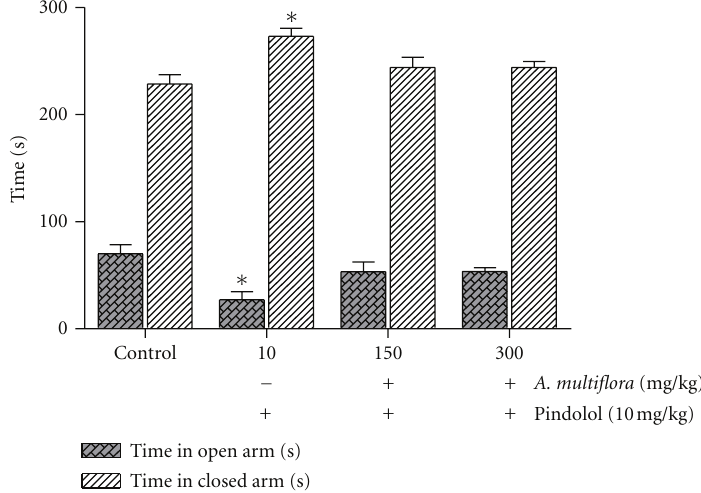
Figure 2: Antagonistic e ff ect of pindolol on the anxiolytic-like e ff ect of the aqueous extract of A. multiflora stem bark. Pindolol (10 mg/kg) was given 30min before the extract and during the same period. Data are expressed as mean ± SEM of the time spent in the closed and open arms in rats given 5min test 30 min after the last administration of the extract. ∗ P < 0 . 05, compared to the vehicle-treated control group, n = 6 rats per